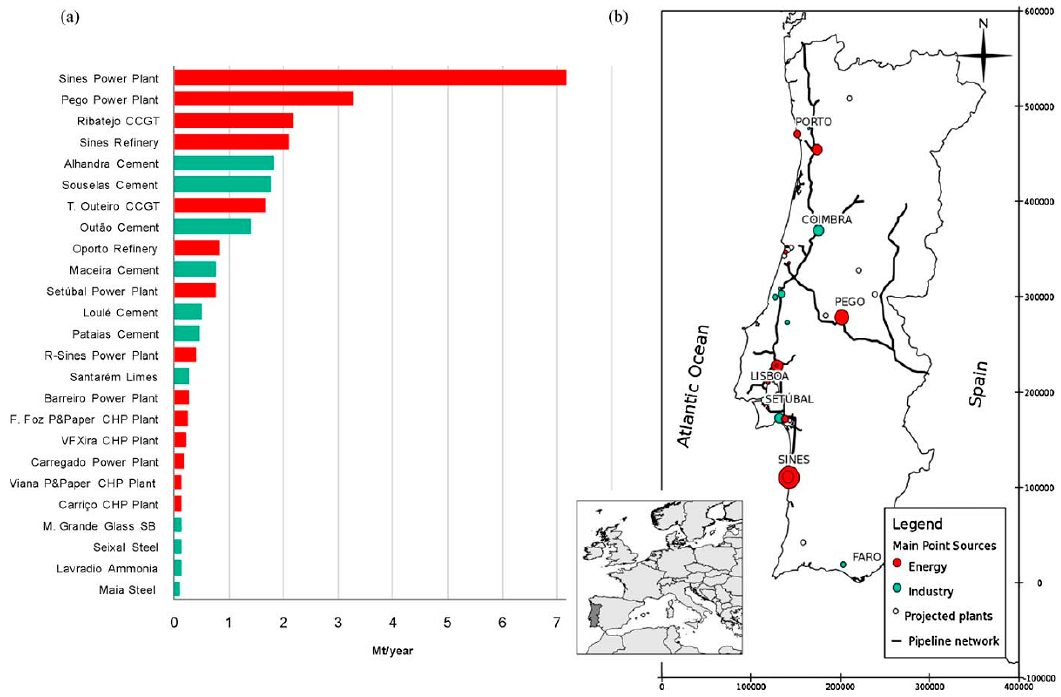
Figure 12. ( a ) CO 2 sources emitting more than 0.1 Mt/year in 2007 and ( b ) location of point